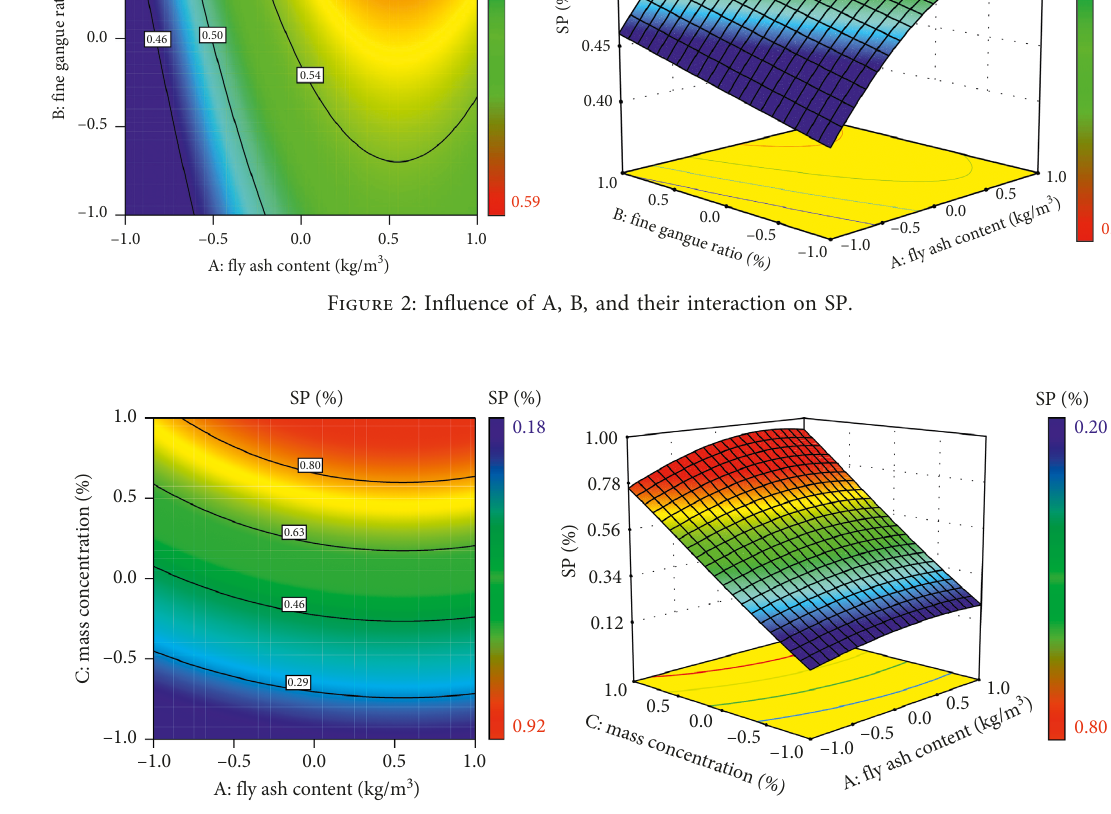
Figure 3: Influence of A, C, and their interaction on SP.